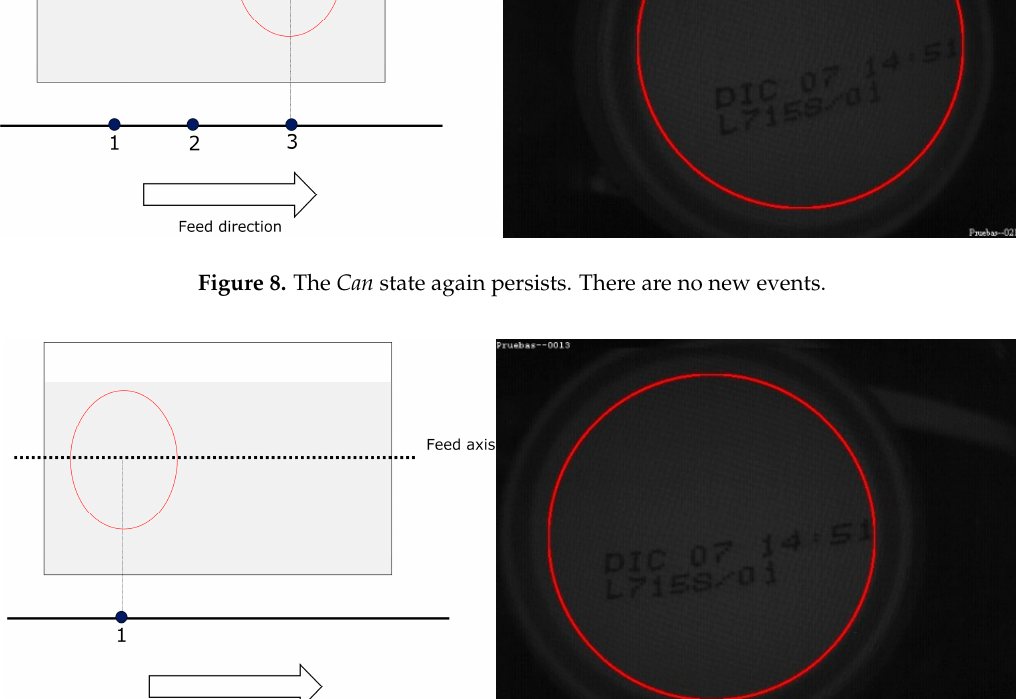
Figure 10. The figure on the left shows the Leave event, and the system enters the no-can state. The figure on the right shows a new Enter event with a fictitious Leave event, which closes the previous Enter event. 2.3. Selection of the Can to Be Validated Using these definitions, we distinguish the following: (a) All frames between an Enter and Leave event are treatable. The rest of the frames are not treatable. (b) All the frames between an Enter and Leave event belong to the same can. Each pair of Enter-Leave events increases the can counter. (c) When a Leave event occurs, the dominant area of interest closest to the centre of the image is chosen as the optimal frame. This is justified because one expects the thin can will be the best centred in the entry field. The centre of the entry field has more homogeneous illumination and better optical conditions than the areas closer to the image borders. (d) In addition, if an acquisition ends prior to an Enter event closed by a Leave event , the frames since the Enter event are discarded . The optimal frame is sent to the validation system. In this way the validation system only works with the best frame available for a particular can (best centred in the entry field). No new acquired frames will be better for this particular can. The validation system never validates the same can more than once.